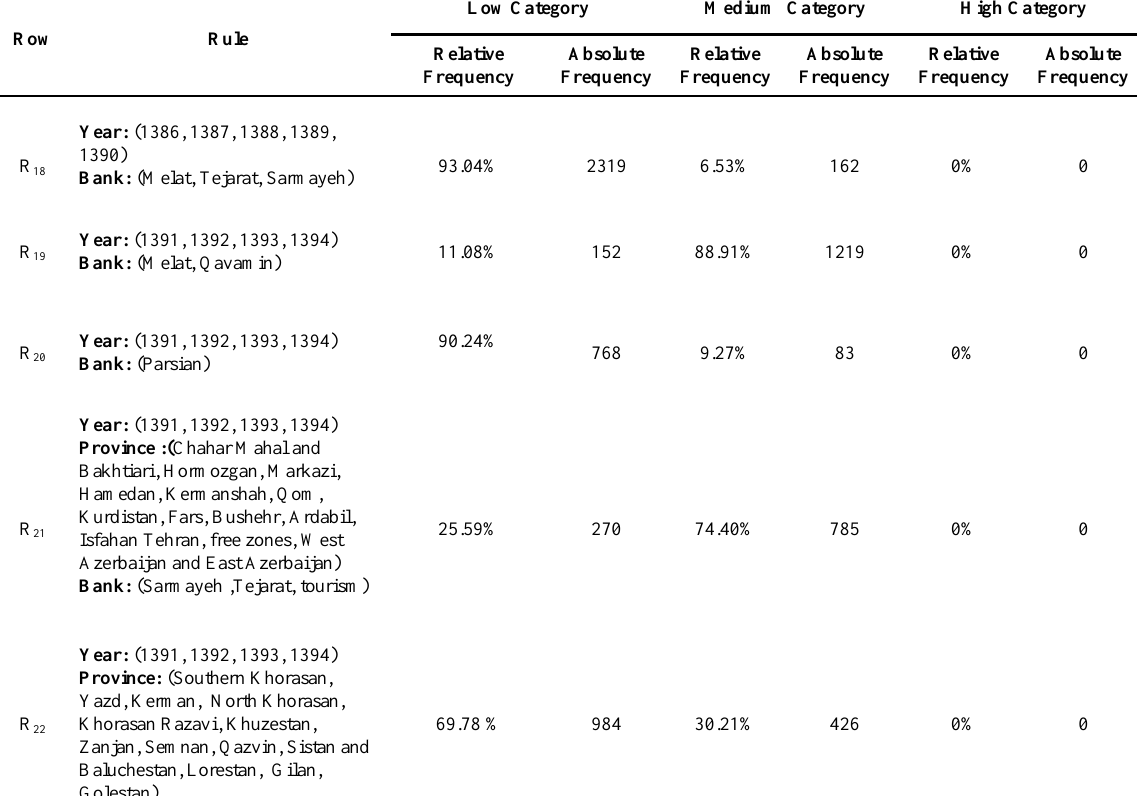
Table 15. Extracted rules of decision tree of Pin Pad transactions with respect to month and